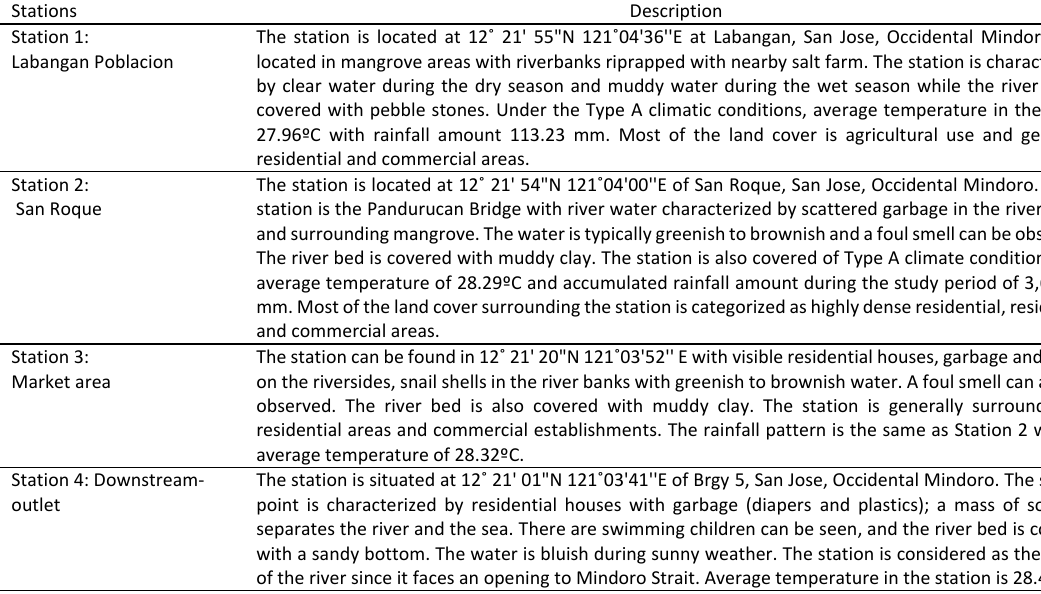
Table 1: Description and profile of sampling station sites (PAG-ASA, 2021)